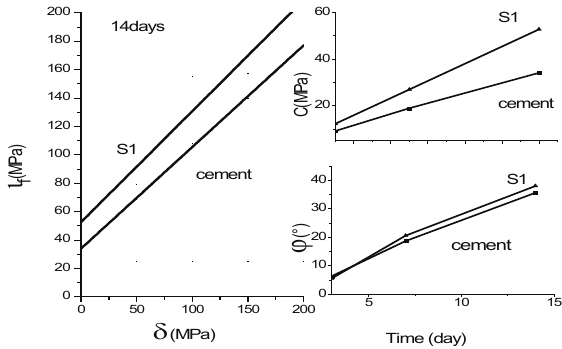
Figure 3: Shear force change of modified sludge.